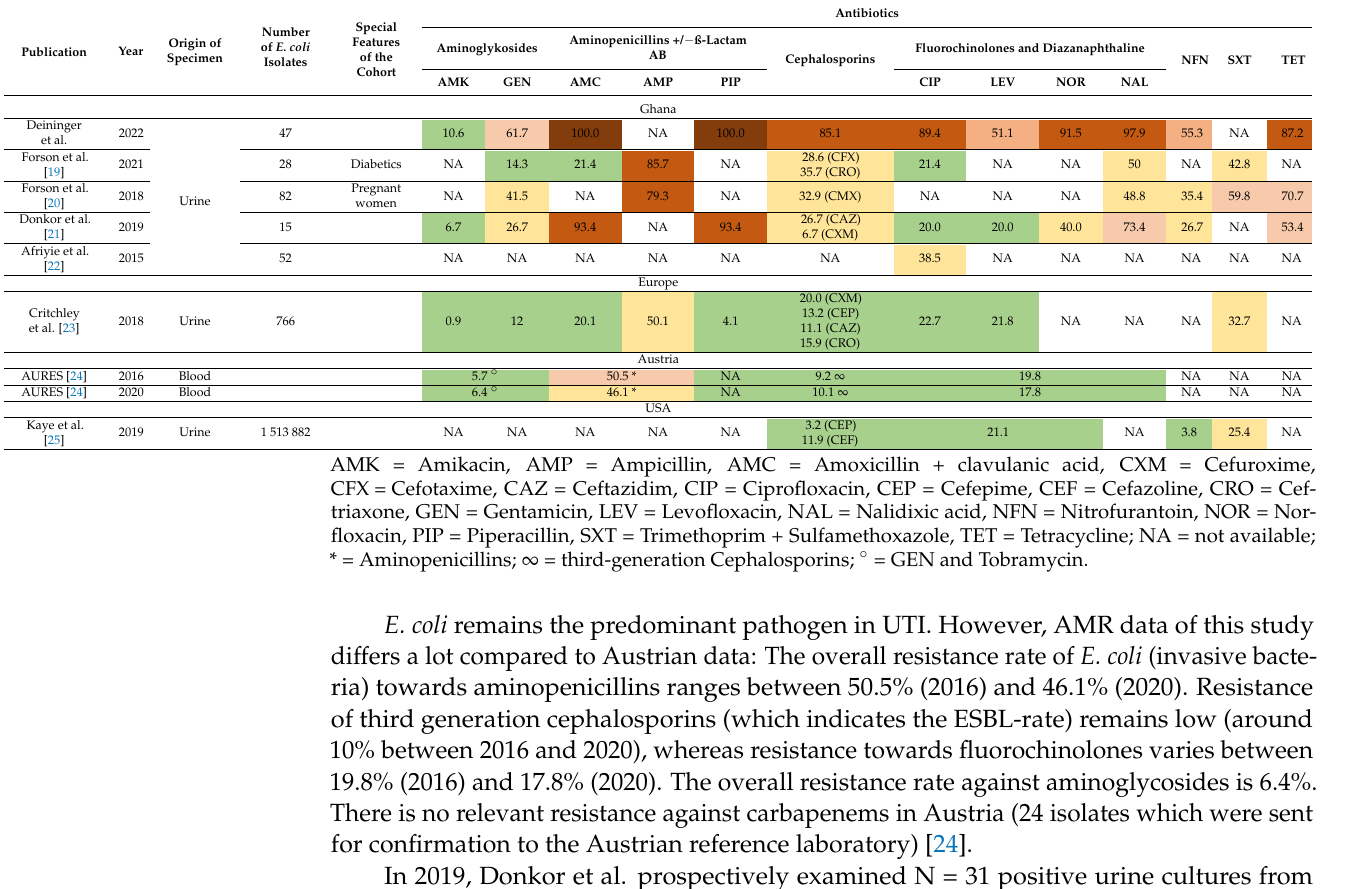
Table 5. Comparison of own data (Deininger et al., 2022) with existing literature on E. coli AMR rates in Ghana, Europe, the USA and the Austrian resistance (AURES) reports from 2016 and